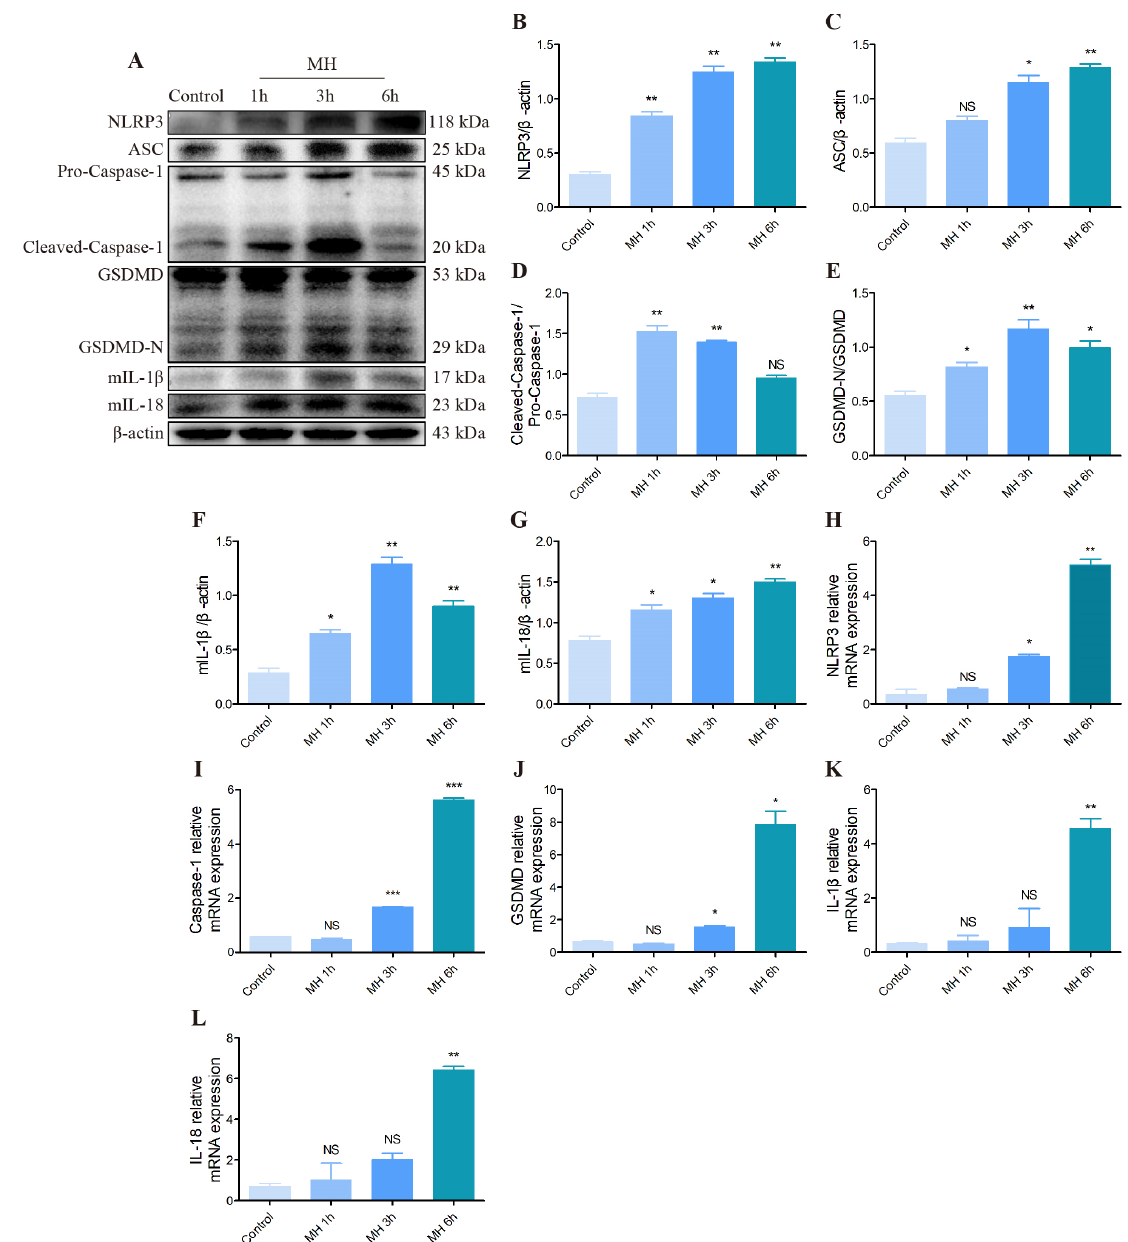
Figure 7. Effect of MH treatment on NLRP3/GSDMD pyroptosis pathway assessed by West- ern blot and qRT-PCR. ( A ) NLRP3, ASC, Caspase-1, GSDMD, IL-1 β , IL-18 and β -actin protein levels in each group. ( B – G ) Quantification of expression levels based on expression ratios of NLRP3/ β -actin, ASC/ β -actin, Cleaved-Caspase-1/Pro-Caspase-1, GSDMD-N/GSDMD, mIL-1 β / β - actin, mIL-18/ β -actin. ( H – L ) The histograms of relative mRNA analysis of NLRP3/ β -actin, Caspase- 1/ β -actin, GSDMD/ β -actin, IL-1 β / β -actin, IL-18/ β -actin. Data are presented as mean ± standard ( n = 3). NS means not significant, * p < 0.05, ** p < 0.01, *** p <